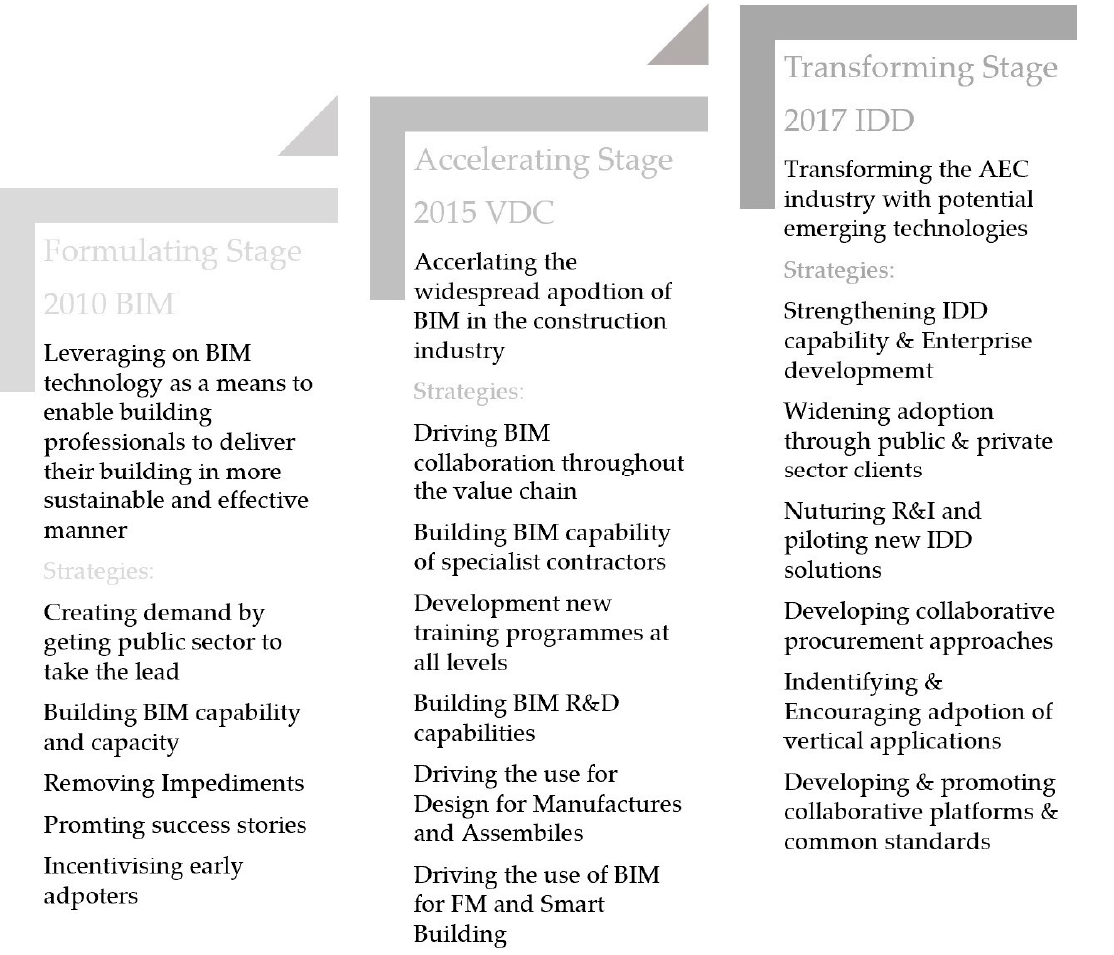
Figure 15. Evolution of BIM policy in Singapore.